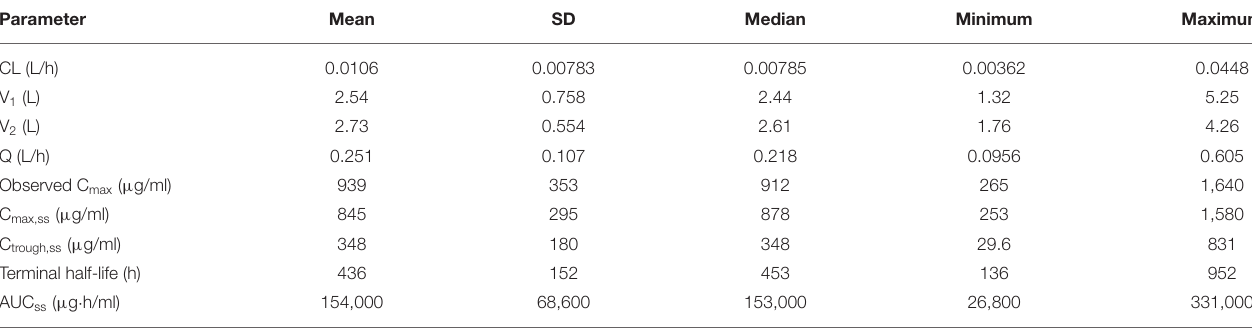
TABLE 1 | Summary of estimated pharmacokinetic